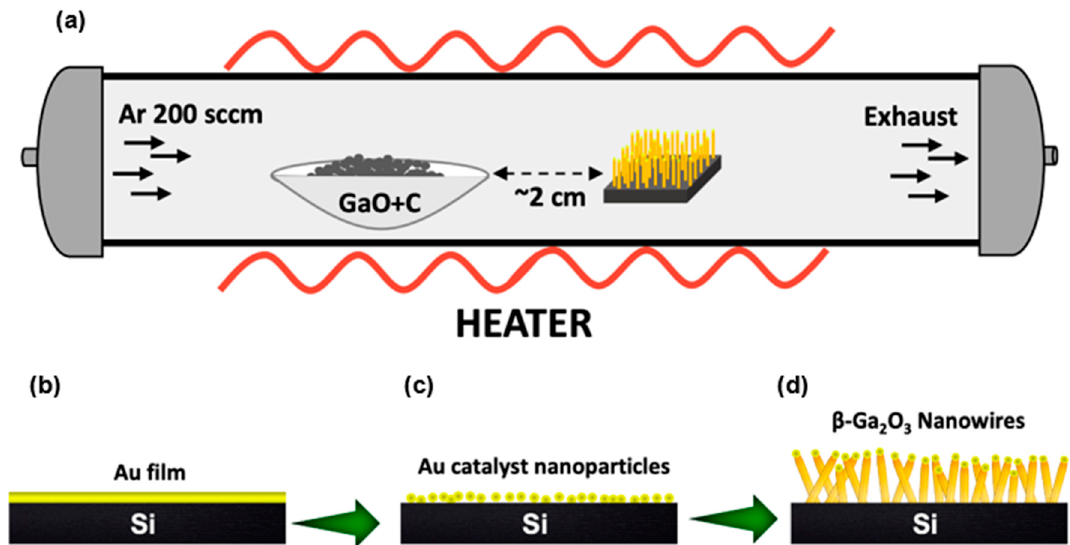
Figure 1. Schematic diagram for the growth of 1D β -Ga 2 O 3 nanostructures on Si (100) substrate through the VLS method. ( a ) Entire setup during the growth process, ( b ) deposition of Au catalyst film on Si (100) substrate by PVD, ( c ) annealing of Au film to form Au eutectic droplets for nanostructure growth, and ( d ) 1D β -Ga 2 O 3 nanowire growth at 1025 °C by VLS method guided by the Au nanoparticles.